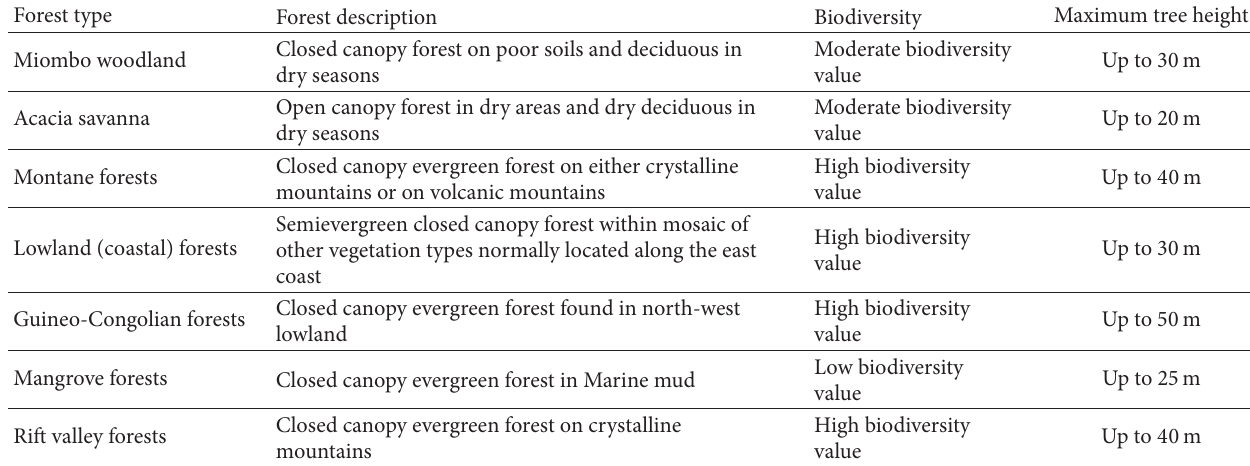
Table 1: Tanzanian forest types, their description and biodiversity